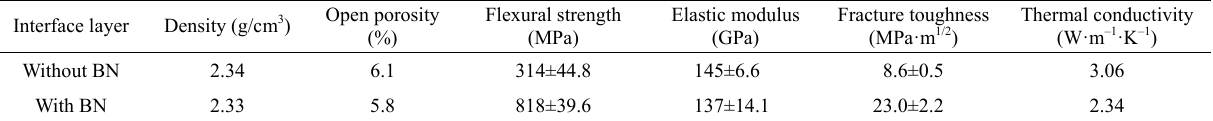
Table 3 Properties of the KD-S SiCf/SiC composites with and without BN interface layer at room